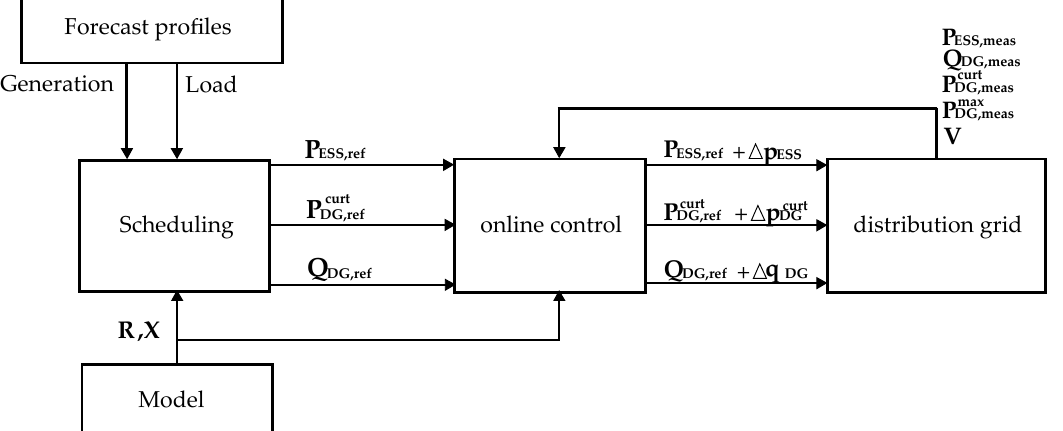
Figure 14. Control structure for Test